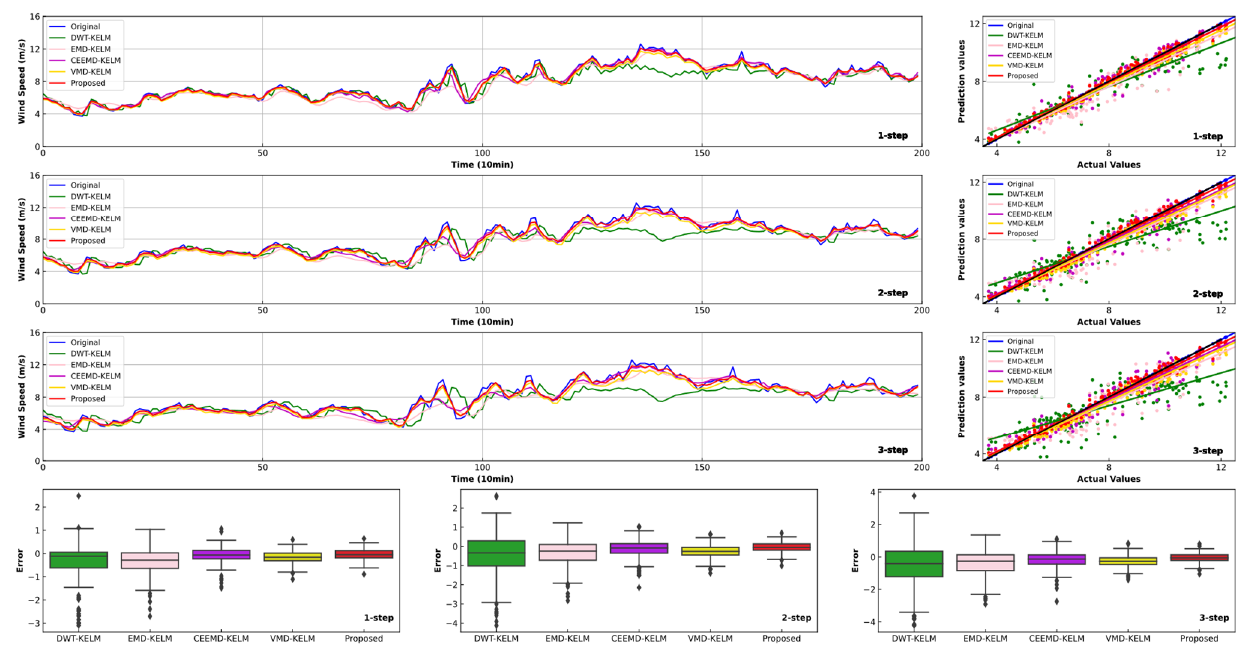
Figure 6. Forecasting performance of decomposed models in one-, two- and three-step ahead forecasting for the summer dataset.